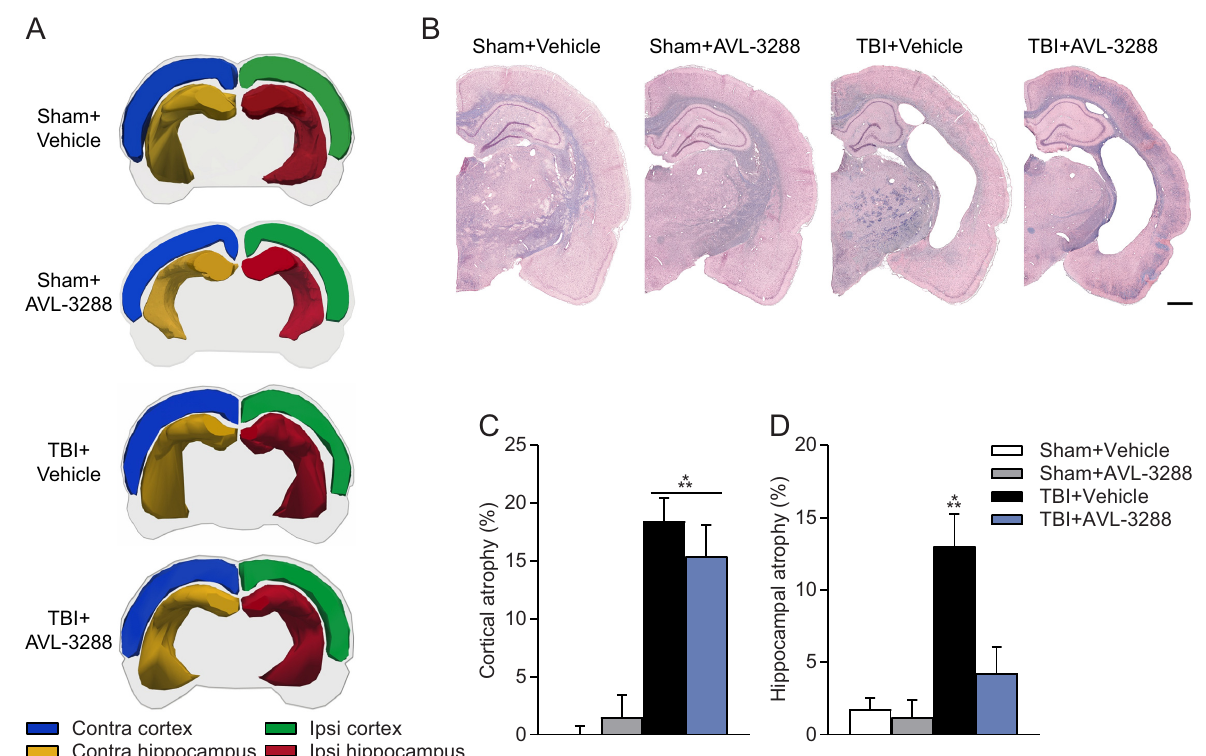
Fig 4. Pathology. Atrophy levels of the cortex and hippocampus. A) Representative 3-dimensional visualizations of brains reconstructed from contours of the ipsilateral (Ipsi) and contralateral (Contra) cortex and hippocampus between bregma levels -3.3 to -6.8 mm. B) Representative H&E plus Luxol fast blue-stained sections at bregma level -3.0 mm. Cortical atrophy was similar between TBI+Vehicle and TBI+AVL-3288 animals. Hippocampal atrophy was modestly reduced in TBI+AVL-3288 animals. Scale bar 1 mm. C) Quantification of atrophy of the ipsilateral parietal cortex. ��� p < 0.001 vs. Sham, two-way ANOVA with Tukey’s HSD post-hoc test. D) Quantification of atrophy of the ipsilateral hippocampus. ��� p < 0.001 vs. Sham+Vehicle, Sham+AVL-3288, TBI+AVL-3288, two-way ANOVA with Tukey’s HSD post-hoc test. Mean ± SEM, n = 10 Sham +Vehicle, n = 8 Sham+AVL-3288, n = 11 TBI+Vehicle, n = 11 TBI+AVL-3288.